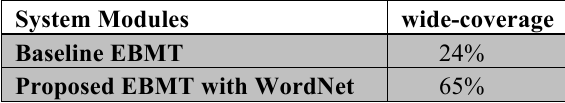
Table 12. Wide-Coverage Comparison